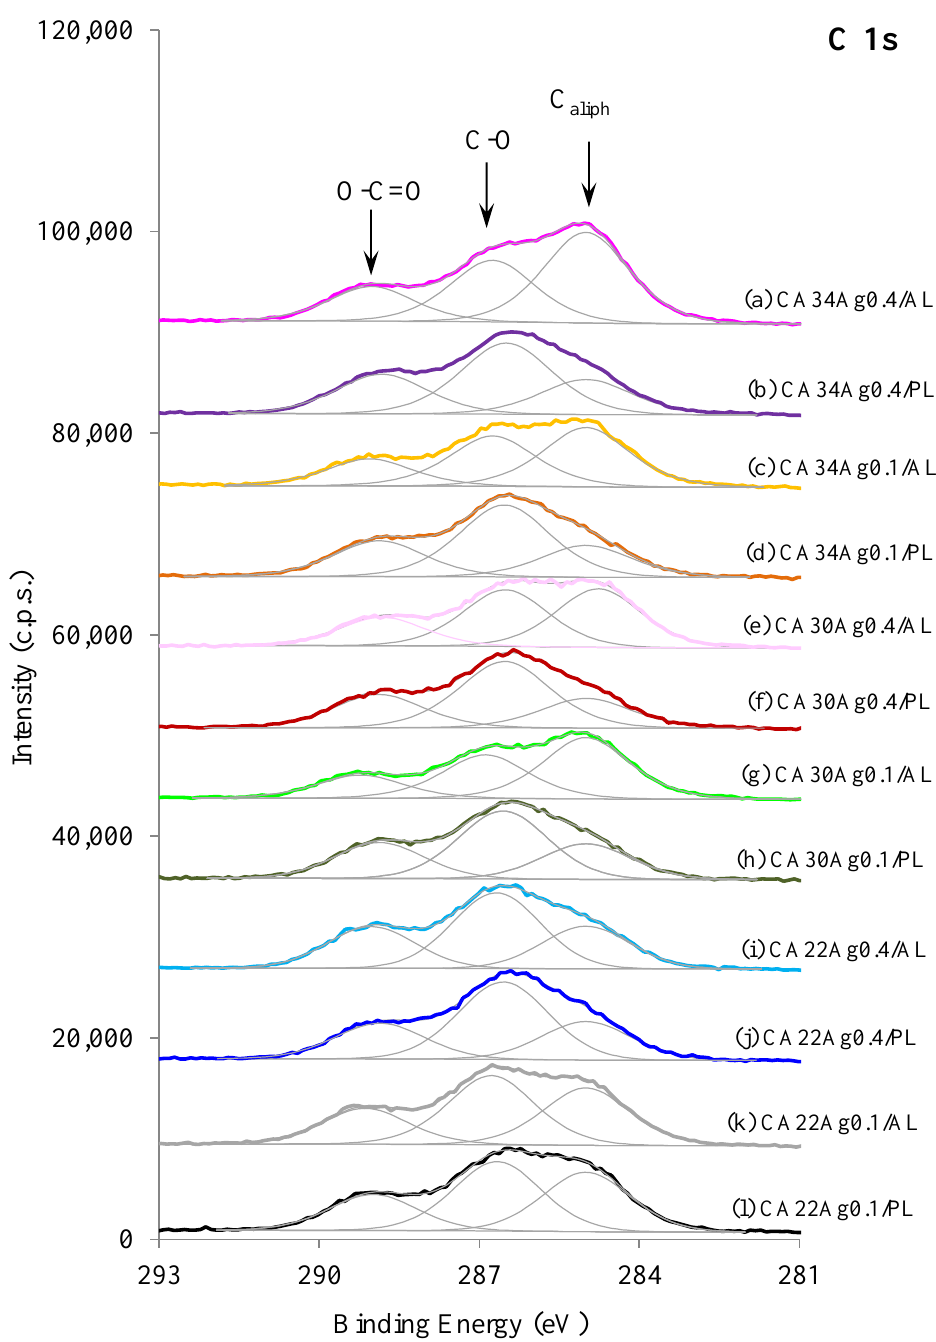
Figure 5. XPS C 1s regions of active layers (AL) and porous layers (PL) of CA/Ag membranes with 0.1% wt Ag and 0.4% wt Ag. A constant was added to each spectrum (except for l) for clarity. The atomic ratios C/O and C3/C1 were computed from the C 1s and O 1s (not shown) regions, where C and O were computed from the total areas of C 1s and O 1s divided by the respective sensitivity factors, C3 is the amount of carbon atoms in O–C=O groups (peak at 289 eV), and C1 is the amount of aliphatic carbons (peak at 285 eV). These ratios can give a clear insight into the differences between AL and PL of CA and CA/Ag membranes. The results are gathered in Figure 6.